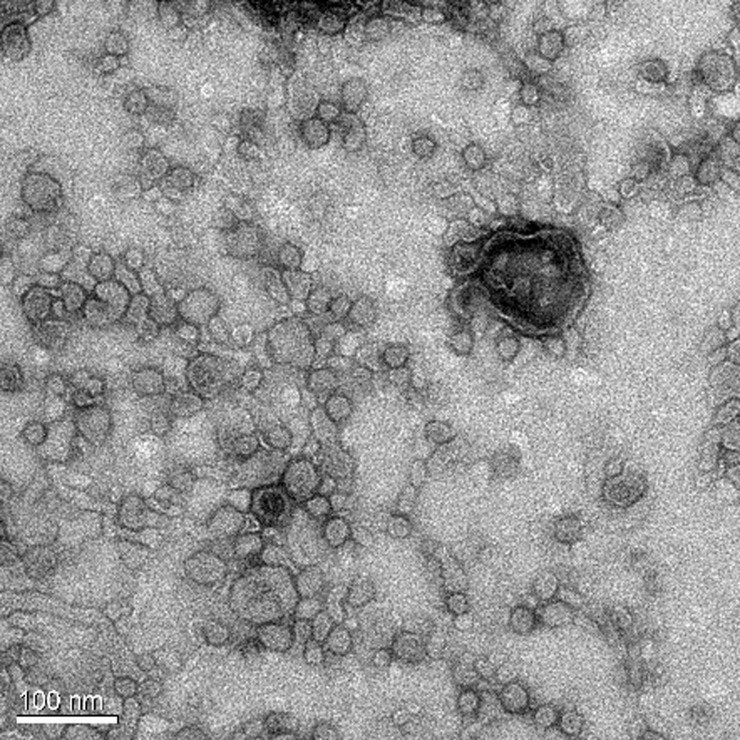
Transmission electron microscope image of wt-OMVs.The bar indicates 100 nm.